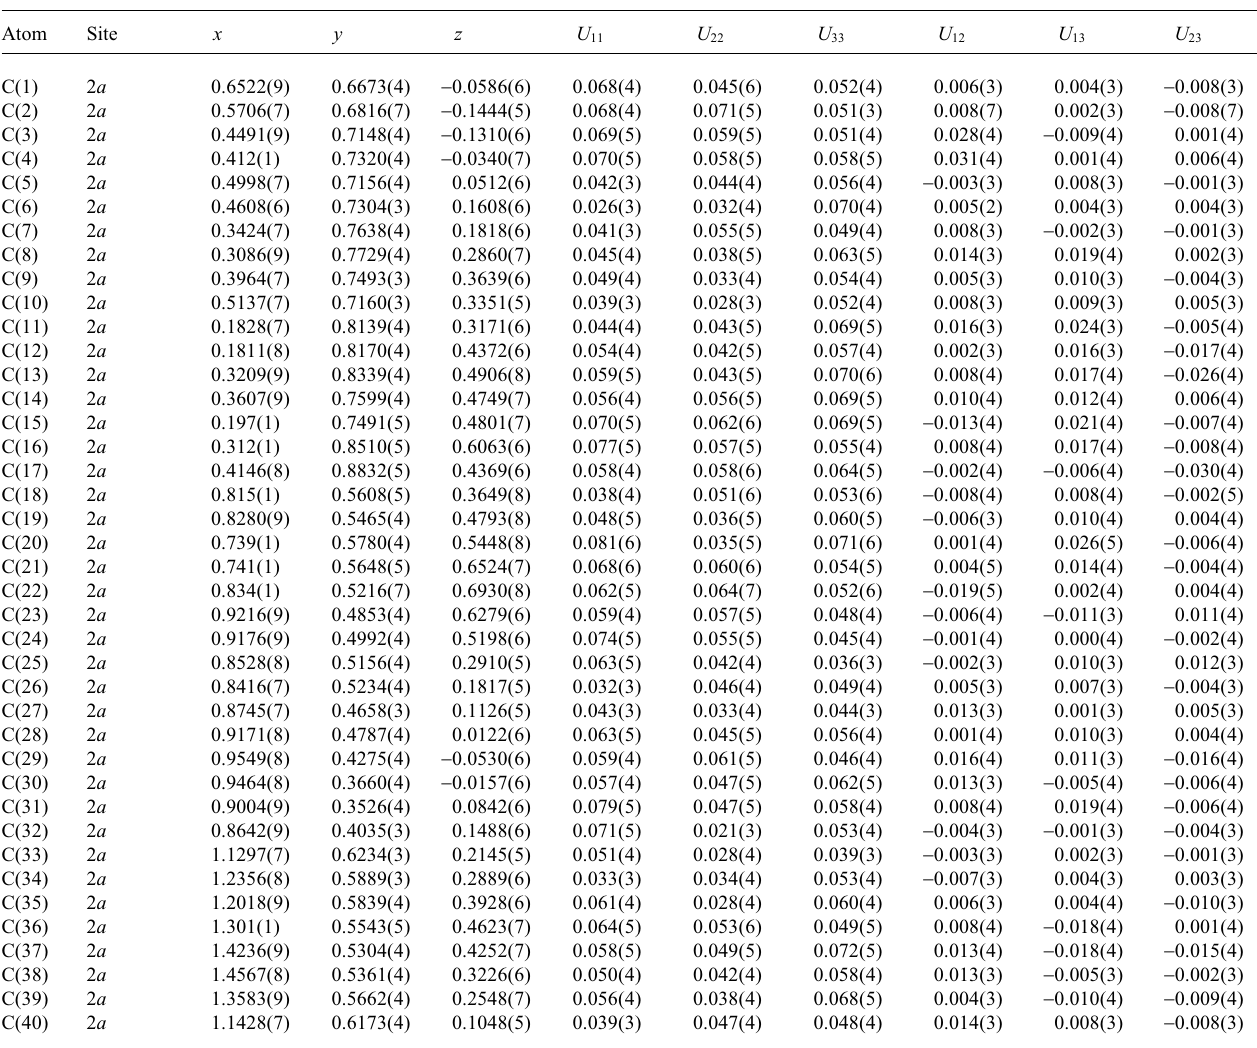
Table 3. Atomic coordinates and displacement parameters (in Å 2